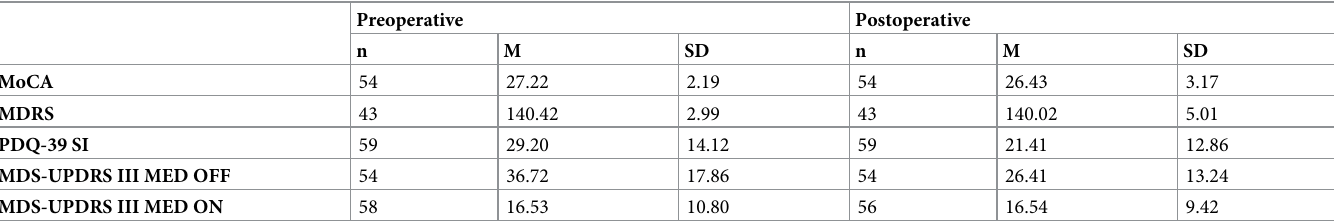
Table 1. Preoperative and postoperative PD patients scores.